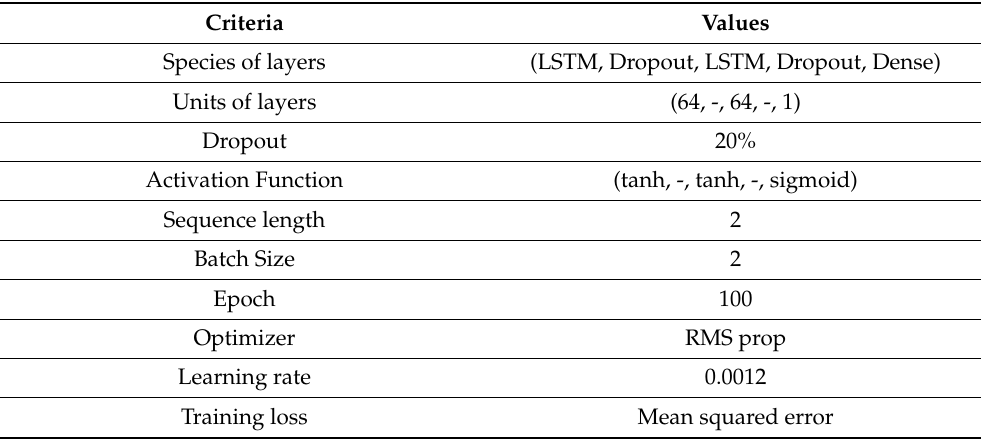
Table 3. Specific hyperparameters and structure of